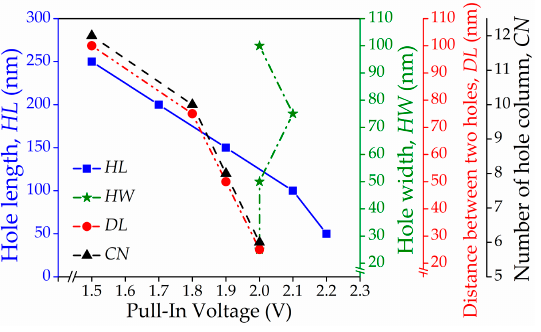
Figure 10. Trends of actuation pull-in voltage against hole length, hole width, distance between two holes, and number of hole column of graphene-based NEM switch device.